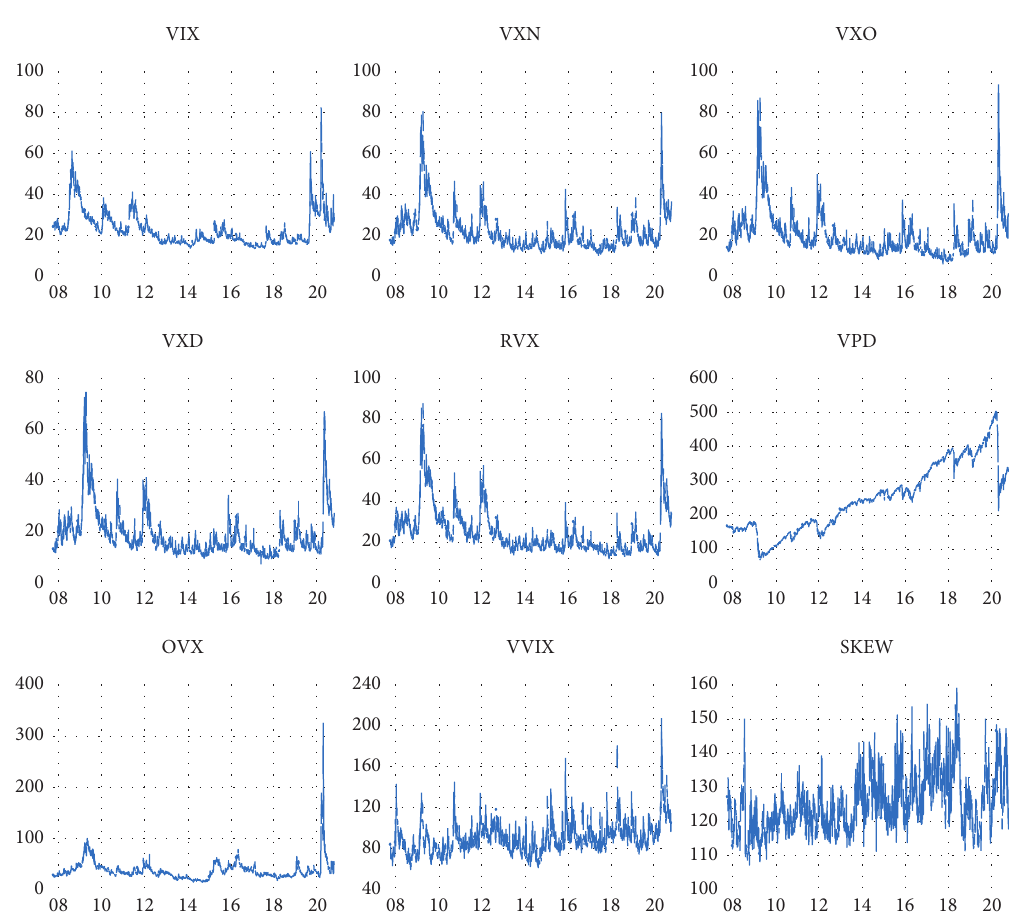
Figure 1: Levels of the nine volatility indices from October 5, 2007, to October 5, 2020. Table 1: Descriptive statistics for the levels of the nine CBOE volatility